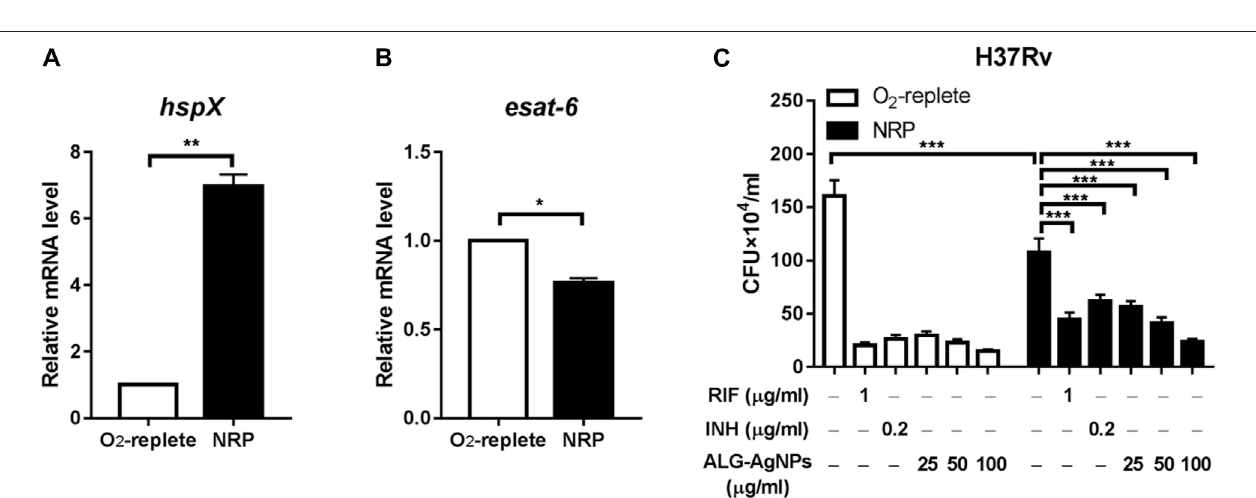
FIGURE 5 | ALG-AgNPs effectively suppressed the growth of dormant-like bacilli in vitro . (A – B) The Mtb strain H37Rv was cultured with or without hypoxia to induce non-replicating persistence (NRP) or not. Then, the gene expression levels associated with the NRP state were assessed by QPCR, speci fi cally (A) hspX and (B) esat-6 . (C) The bacteria were treated with PBS, rifampicin (RIF) (1 μ g/ml), isoniazid (INH) (0.2 μ g/ml), or different amounts of ALG-AgNPs (25, 50, and 100 μ g/ml) in the NRP state or not (O 2 -replete) for 5 days. The bacterial growth was determined by CFU analysis on Middlebrook 7H10 agar and expressed as the number of CFU × 10 4 /ml. NRP: non-replicating persistence. RIF: rifampicin. INH: isoniazid. Data represent mean ± SEM of 3 experiments. * p < 0.05; ** p < 0.01; *** p < 0.001.